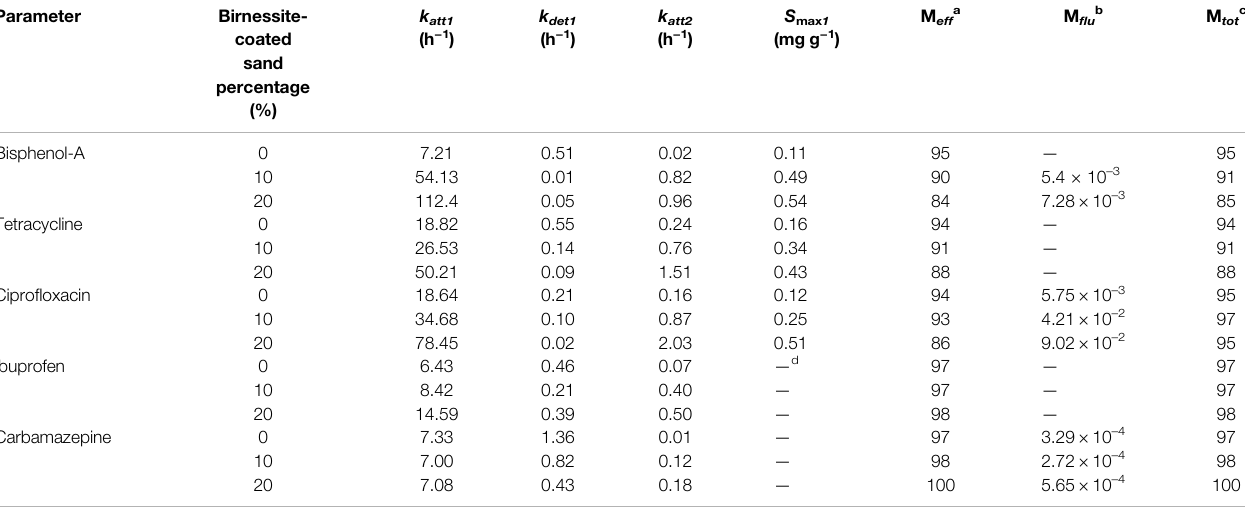
TABLE 3 | Fitted transport parameters and mass recovery of fi ve PPCPs. Parameter